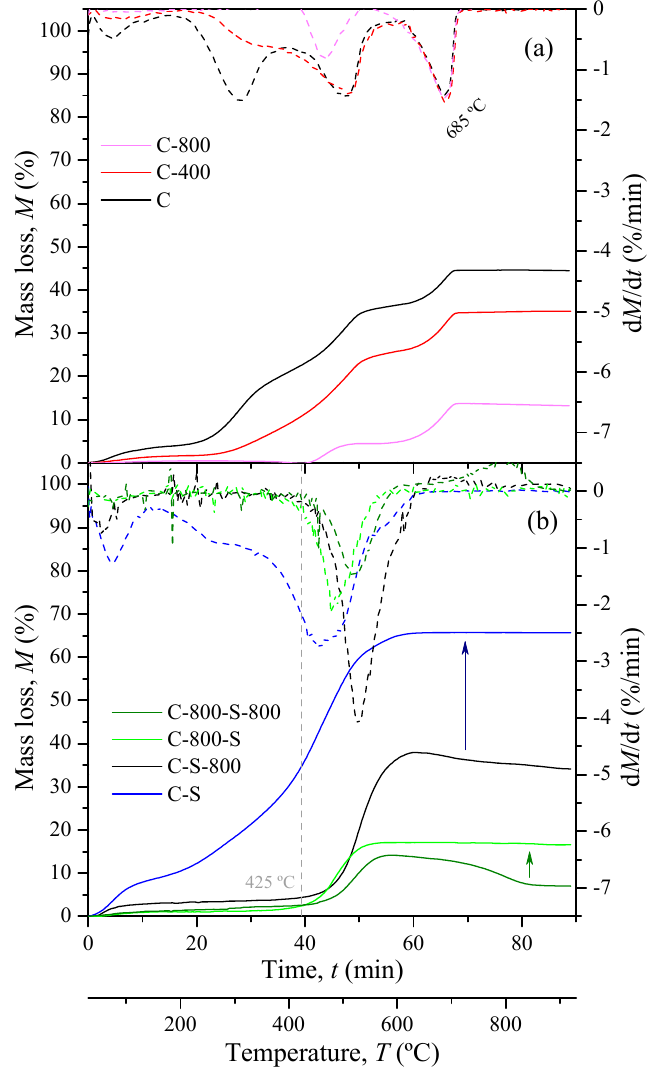
Figure 1. Mass loss obtained by TGA and corresponding TGA derivatives of the samples prepared by thermal treatment ( a ) and both thermal and H 2 SO 4 treatment ( b ).